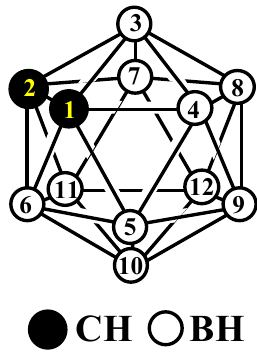
Figure 1. Atom numeration in ortho -carborane 1,2-C 2 B 10 H 12 .